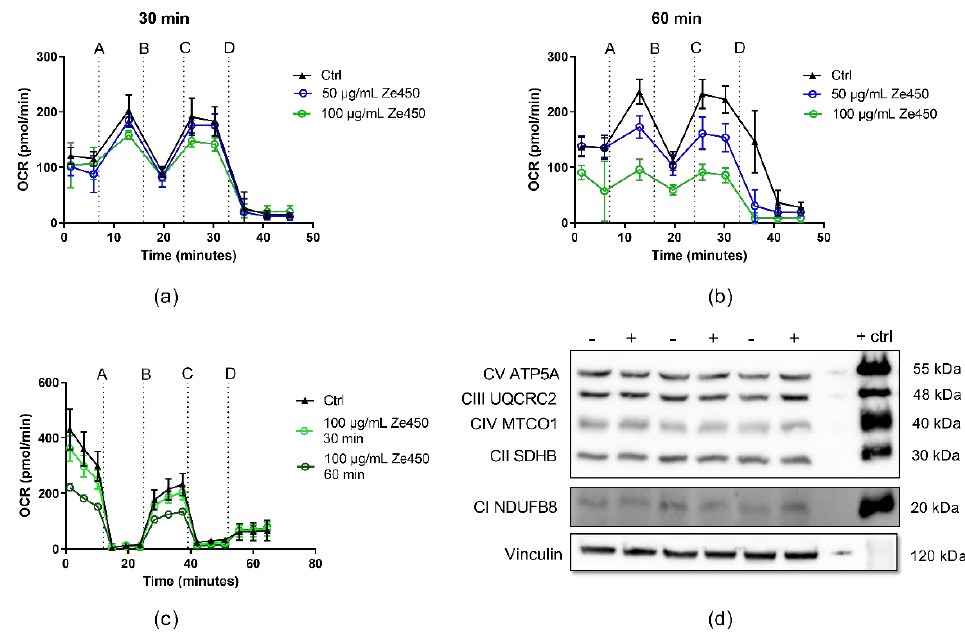
Figure 2. Ze 450 reduces mitochondrial respiration. ( a , b ) Oxygen consumption rate (OCR) was analyzed after 30 and 60 min of incubation with Ze 450 (50 and 100 µ g/mL). ADP (port A), oligomycin (port B), FCCP (port C) and antimycin A (port D) were injected, successively. ( c ) OCR was analyzed after 30 and 60 min of incubation with Ze 450 (50 and 100 µ g/mL). Rotenone (port A), FCCP (port B), antimycin A (port C) and ascorbate/TMPD (port D) were injected, successively. ( d ) depicts an immunoblot. Relative protein levels of the five electron transport chain complexes (CI-CV) were assessed in HT22 cells treated with 100 µ g/mL Ze 450 for 16 h compared to untreated control ( − control, + Ze 450). Rat cortical mitochondria served as a positive control (+ ctrl); ANOVA, Scheff é ’s